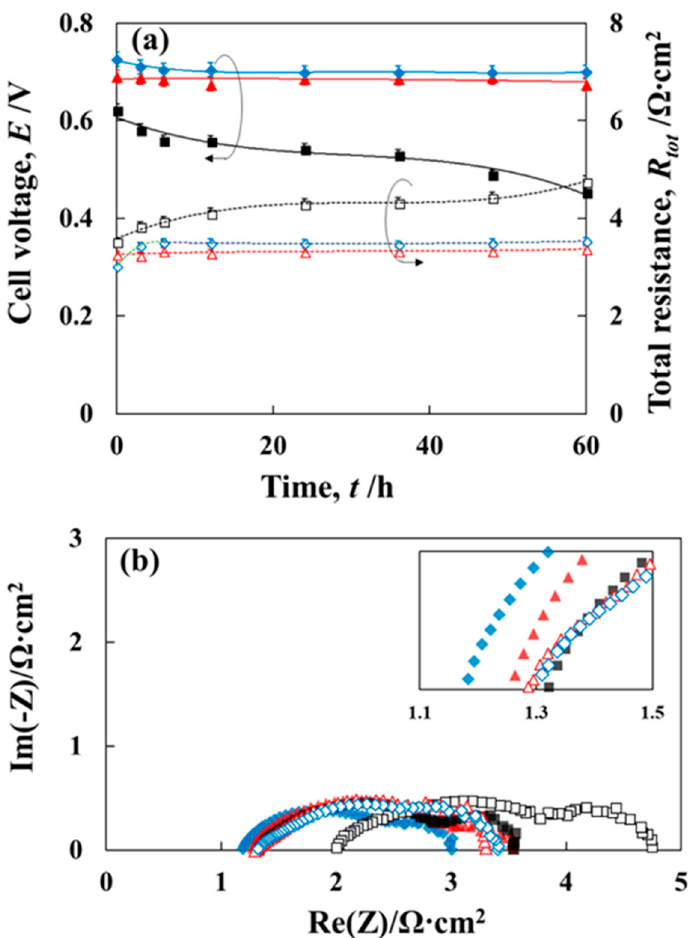
Figure 6. ( a ) The cell voltage (closed symbol) stability and the total resistance (open symbols) for the Ni 1–X Co X cells with time at a constant current at 750 °C for the CH 4 supply: x = 0 ( ■ , □ ); x = 0.15 ( ▲ , △ ); x = 0.25 ( ◆ , ◇ ). ( b ) The electrochemical impedance spectra measured at OCV before and after the prolonged test shown in (a): x = 0 ( ■ : 0 h, □ :60 h); x = 0.15 ( ▲ :0 h, △ : 60 h); x = 0.25 ( ◆ : 0 h, ◇ :60 h).